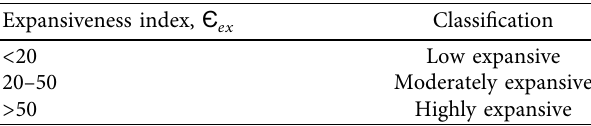
Table 5: Soil expansivity based on expansiveness index. Table 6: Free-swell index (FSI) and specific gravity of the soil sample from all test pits.